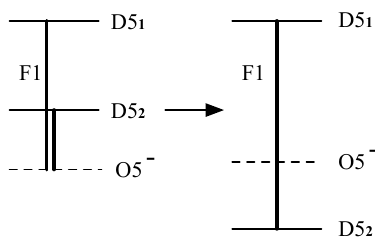
Figure 7 . Fundamental strings in the brane setup with D5 branes and an O 5 - plane.